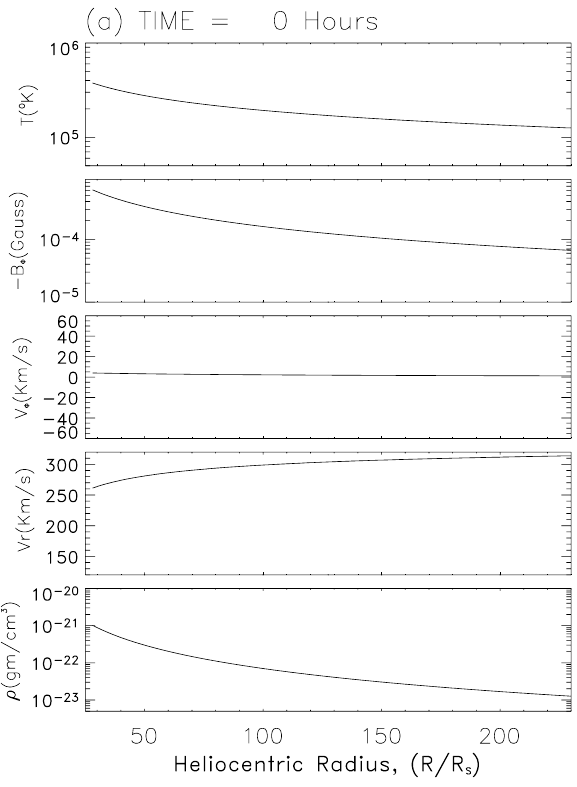
Fig. 1. The initial representative steady-state of the solar wind. Note that the B φ direction is in the direction of a typical, Archimedean IMF outward